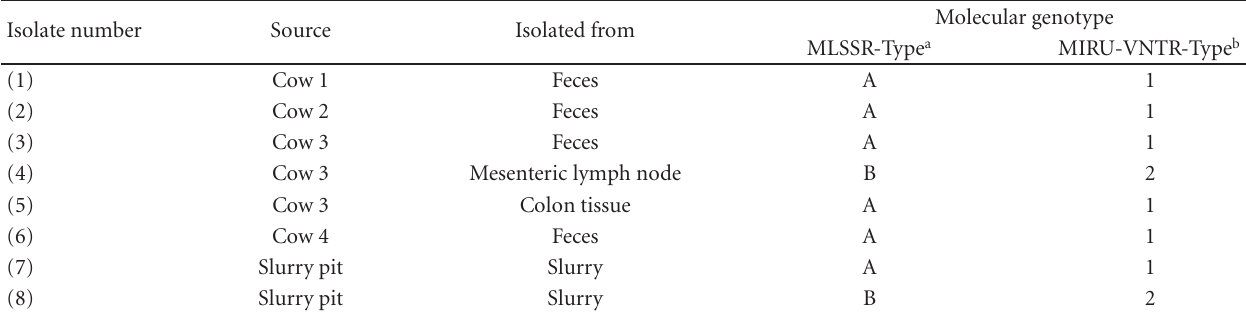
Table 5: Isolates of Mycobacterium avium subsp. paratuberculosis recovered in a dairy herd. Isolate